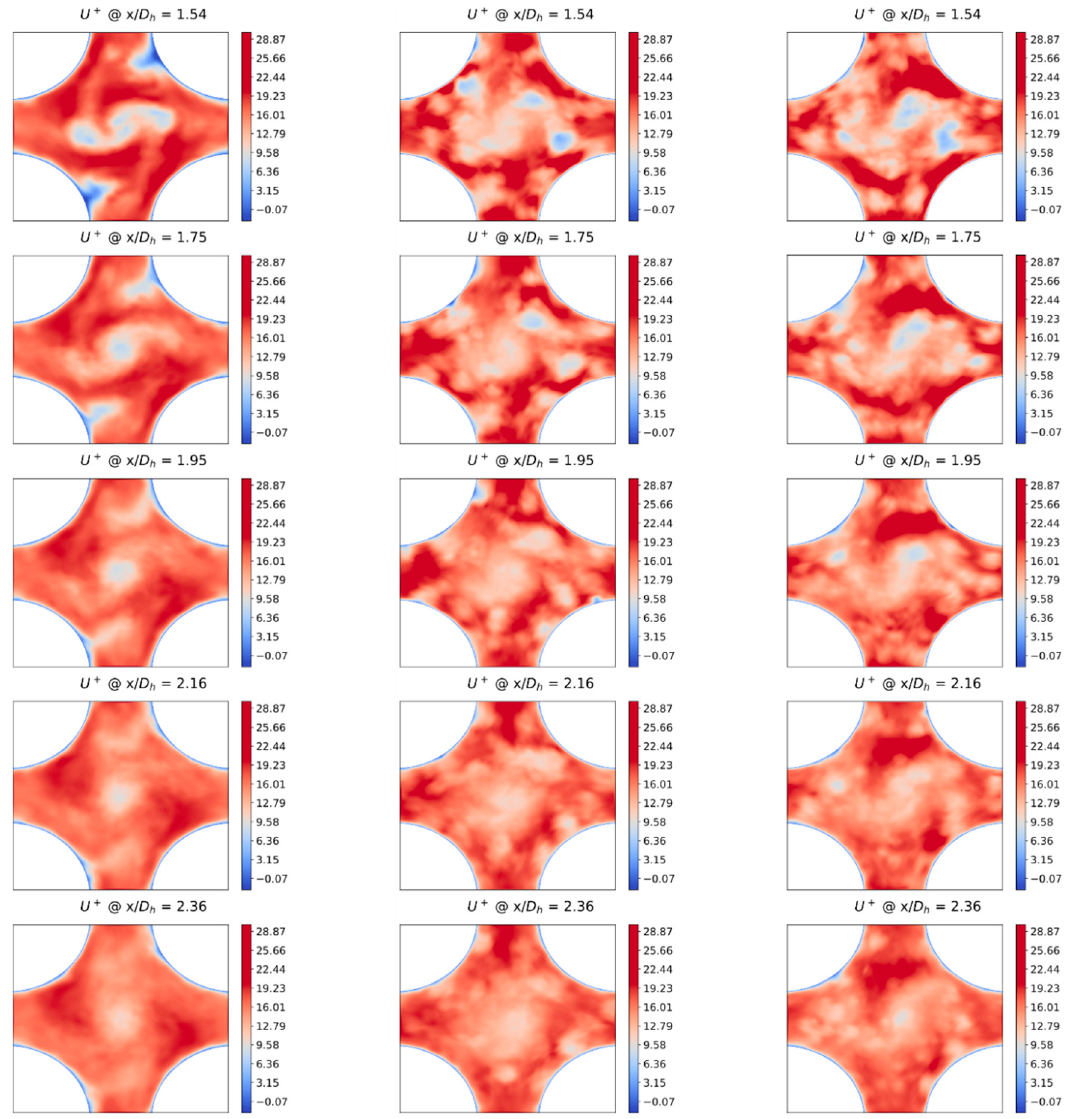
Figure 10. Axial evolution of downstream normalized mean streamwise velocity for the single-phase ( left ), We40 ( middle ) and We80 ( right ) cases.